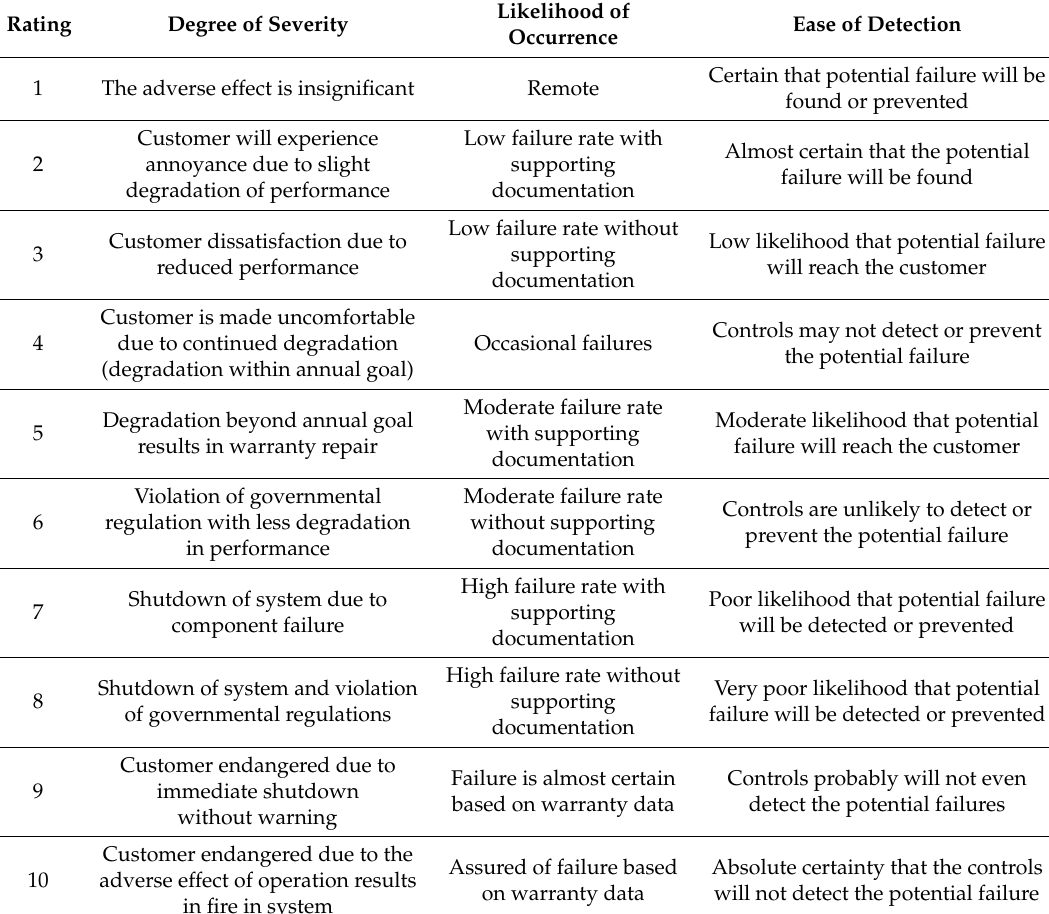
Table 3. Criticality analysis for ceramic